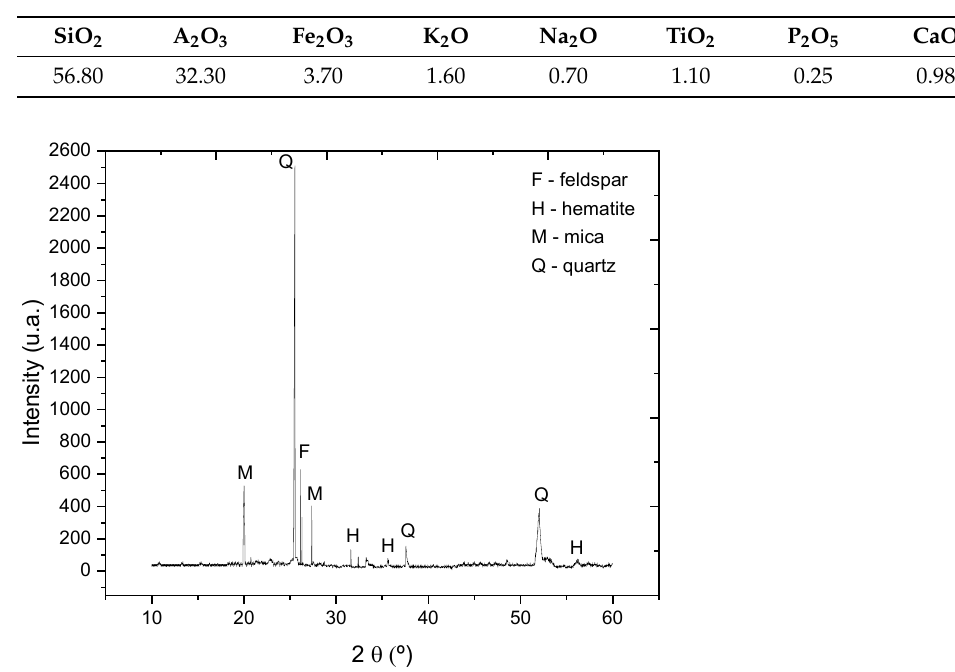
Table 2. Chemical composition (%) of the waste (CCW).